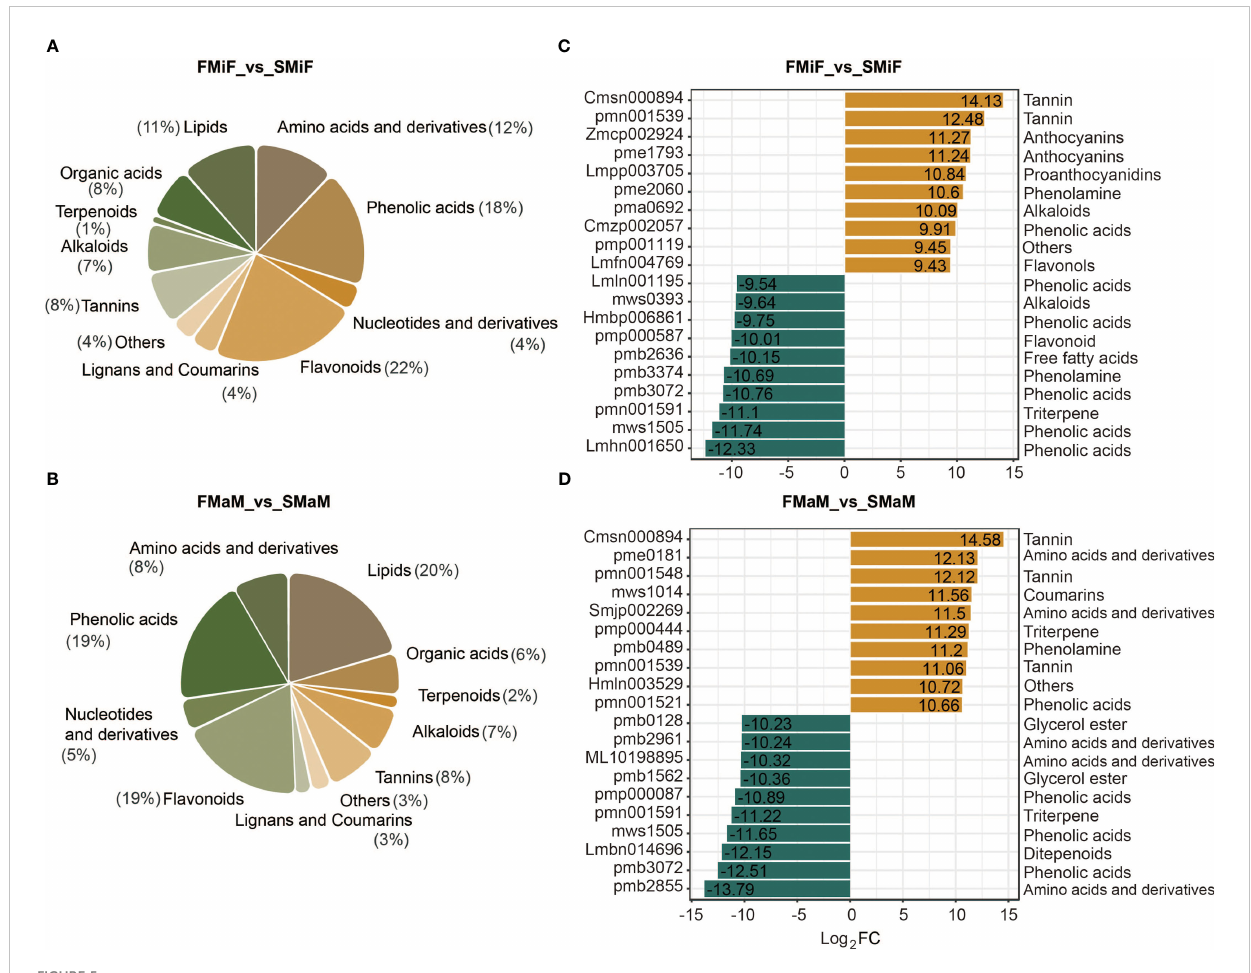
FIGURE 5 Analysis of metabolite differences between fi rst and secondary fl owers. (A) Metabolite species in FMiF_vs_SMiF. (B) Metabolite species in FMaM_vs_SMaM. (C) Differential metabolite upregulation and downregulation of the top 10 metabolites in FMiF_vs_SMiF. (D) Differential metabolite upregulation and downregulation of the top 10 metabolites in